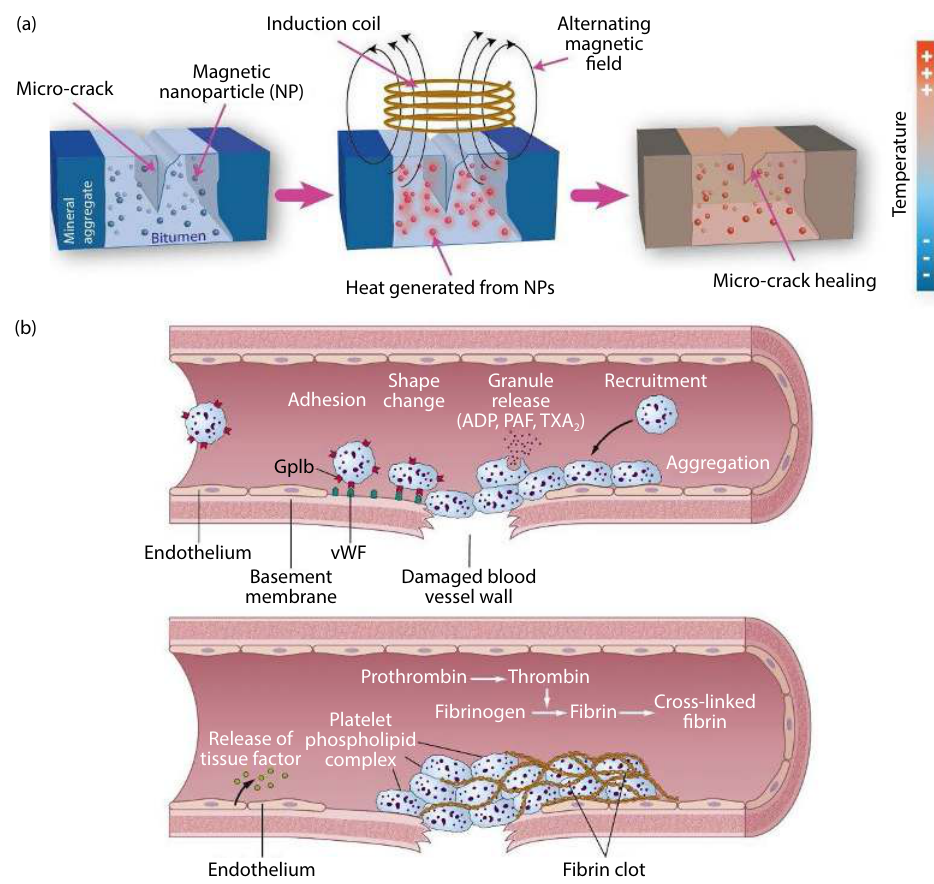
Fig. 16 Inspirations for designing self-healing dielectrics by melting interdiffusion. ( a ) A schematic of healing mechanical damage by incorporating magnetic nanoparticles in bitumen matrix. A treatment of oscillating magnetic field is required (reprinted with permission from ref. [209], © 2016 Elsevier). ( b ) The self-healing process of a vascular injury. Platelets aggregate at the injury site and form clot to stop bleeding. The aggregation behaviour of platelets serves as a bioinspiration for de- fect-targeted self-healing strategy (reprinted with permission from ref. [215], © 2020